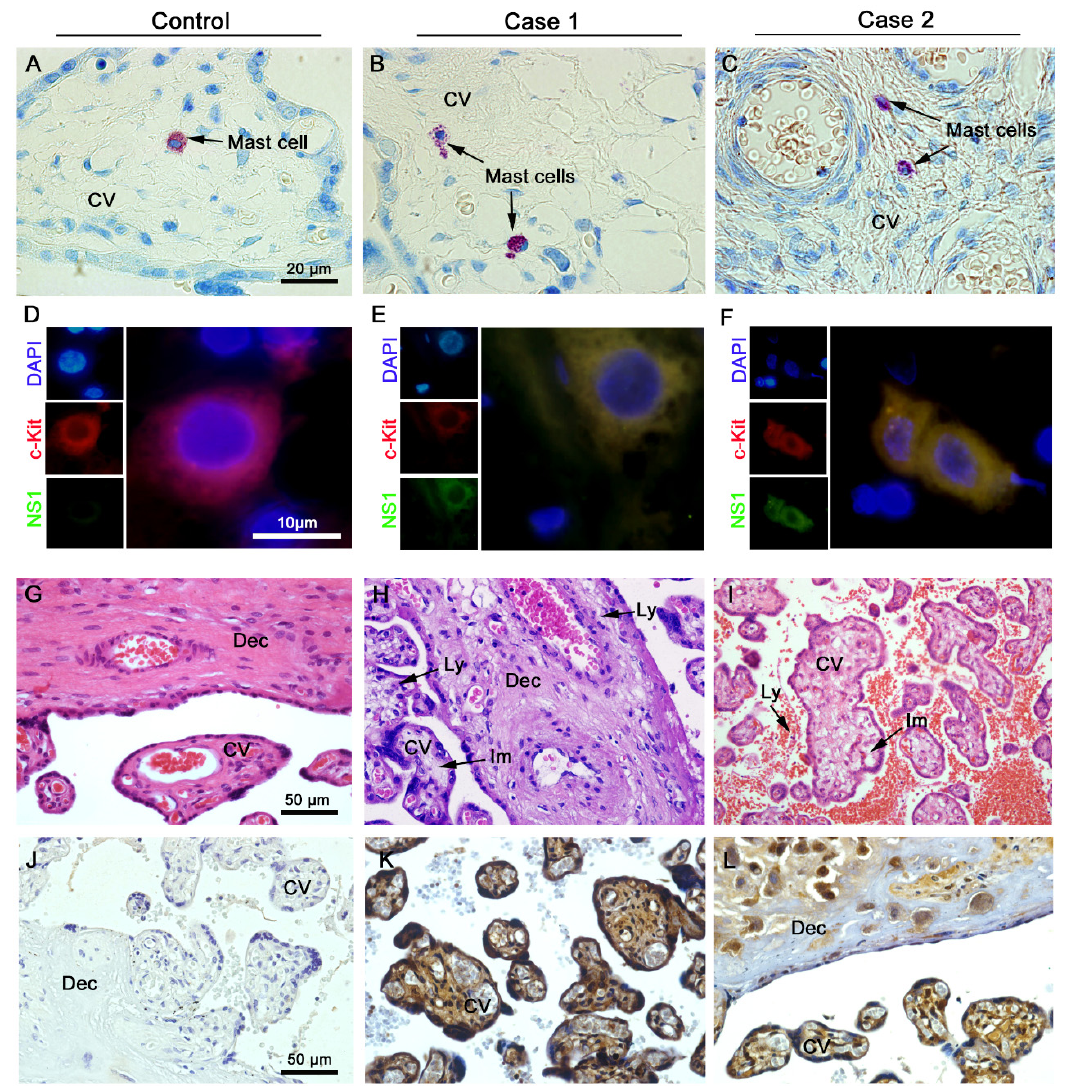
Figure 1. Detection of ZIKV infected mast cells in placental tissue from seropositve mothers. Placentae were collected from mothers infected or not with ZIKV immediately after childbirth and preserved in formadehyde. ( A – C ) Brightfield images of sections stained with Toluidine Blue showing metacromatic granules (purple, arrows) in mast calls. ( D – F ) Immunofluorescent images of DAPI (nuclei; blue), c-Kit (mast cell marker; red) and NS1 (ZIKV marker; green) showing ZIKV infected mast cells with both red and green fluorscence. No NS1 antigen was observed in any sections from the control placenta. The histopathological analysis of the H&E stained placentae showed normal aspects